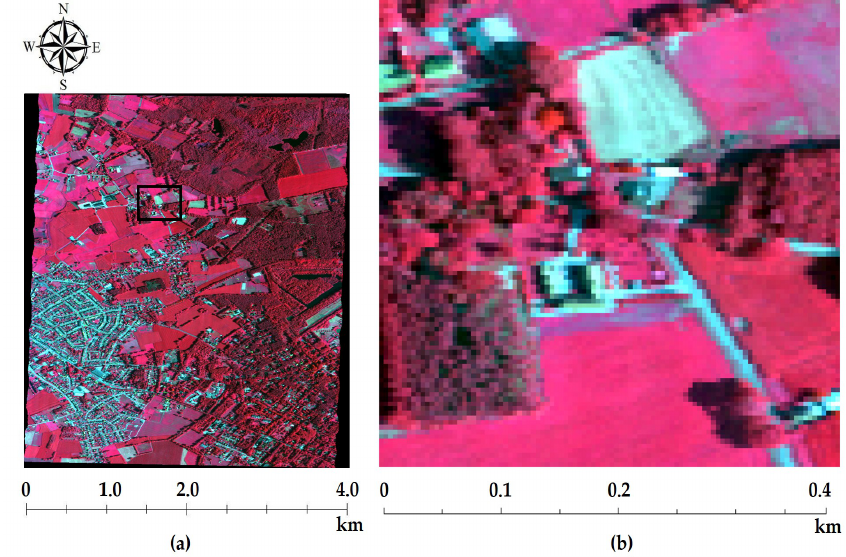
Figure 7. False color representation of the real APEX image ( a ) and the experimental sub-scene ( b ) for the Liereman area (within 51.30653 ◦ N, 5.013669 ◦ E and 51.33816 ◦ N, 4.984975 ◦ E) in